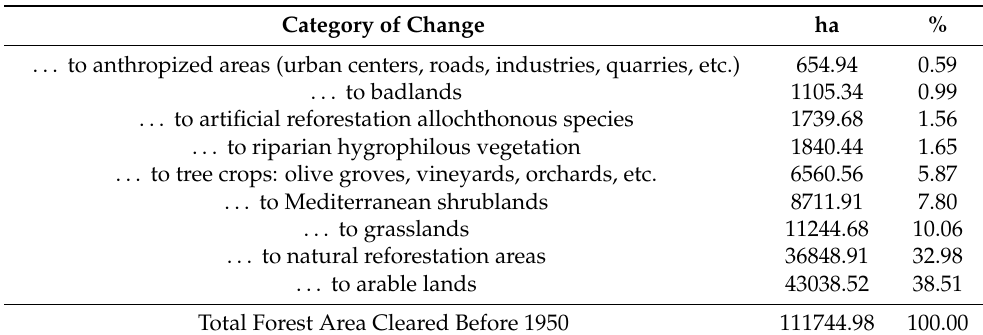
Figure 9. Forest areas cleared prior to 1950 ( left ) and mapping of how forest areas cleared prior to 1950 were transformed ( right ). Table 7. How forest areas cleared prior to 1950 have changed; for each category into which they have changed, the acres and percentage to total are